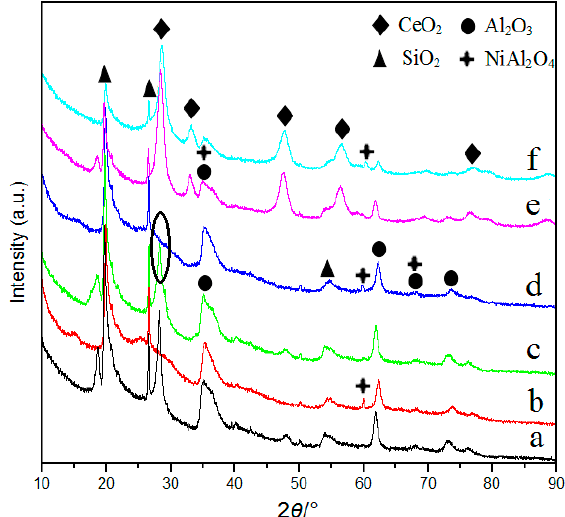
Figure 4. Long-angle XRD patterns. ( a ) MMT; ( b ) AlNi-PILC; ( c ) Pd/MMT; ( d ) Pd/AlNi-PILC; ( e ) Pd/12.5% Ce/MMT; ( f ) Pd/12.5% Ce/AlNi-PILC.